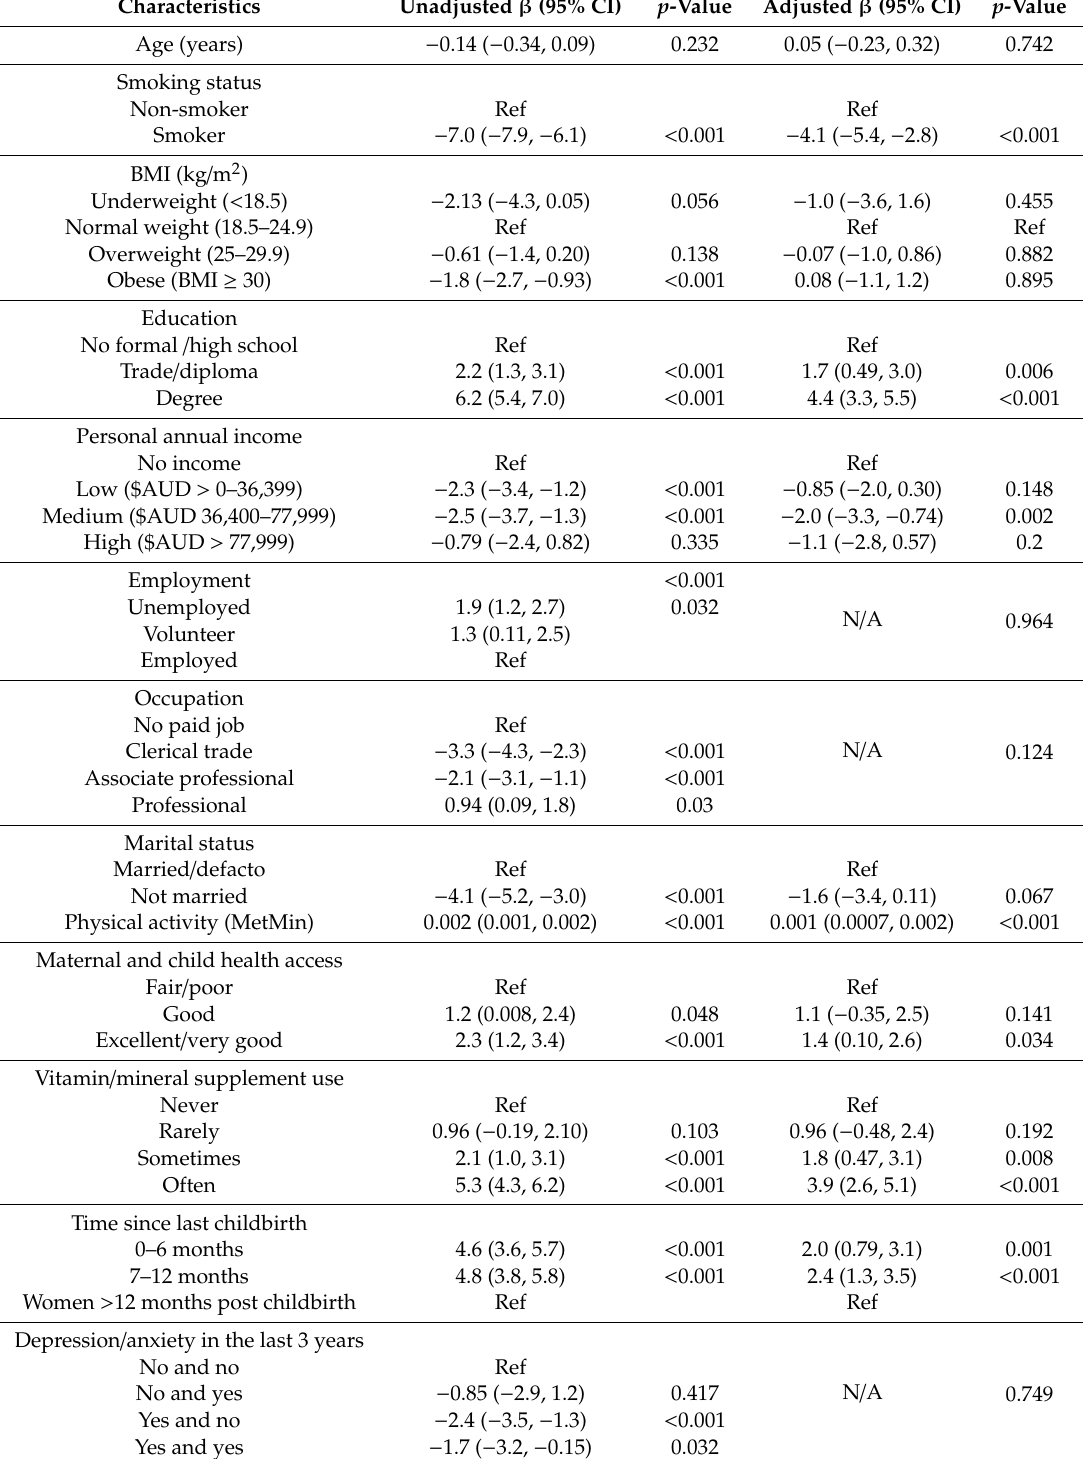
Table 4. Contributors of demographic and anthropometric factors to total diet quality in all